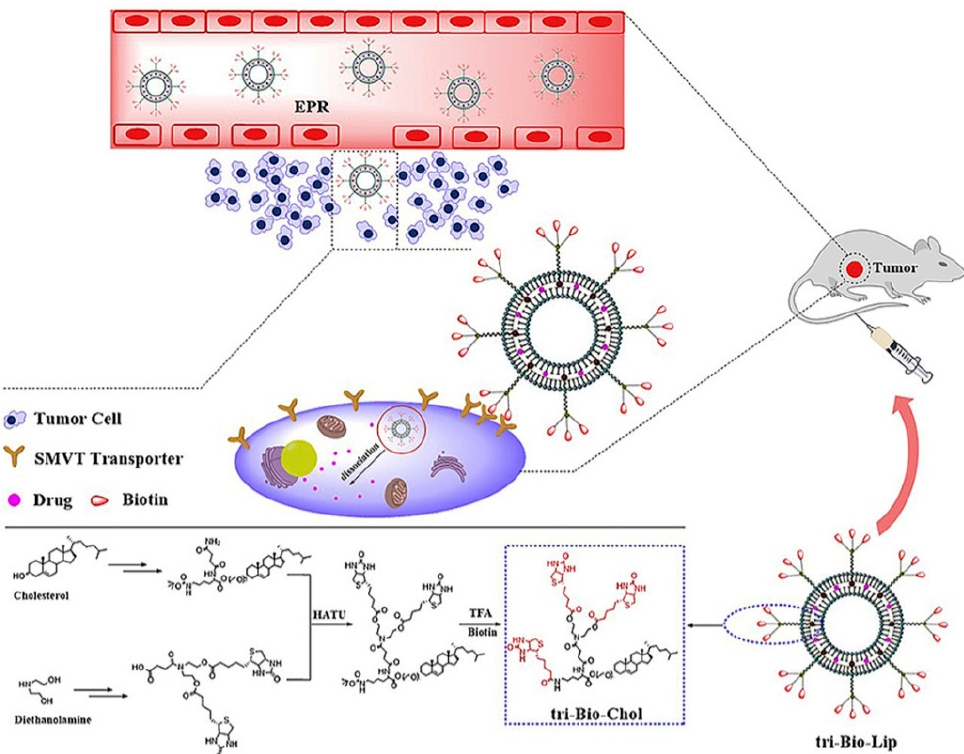
Figure 3. Schematic representation of the tri-Bio-Lip effective drug delivery system to inhibit two kinds of cancer cell lines, mice breast cancer cell line (4T1) and human breast cancer cell lines (MCF-7), respectively. Reproduced with permission from ref. [89] Copyright © 2020, Elsevier.